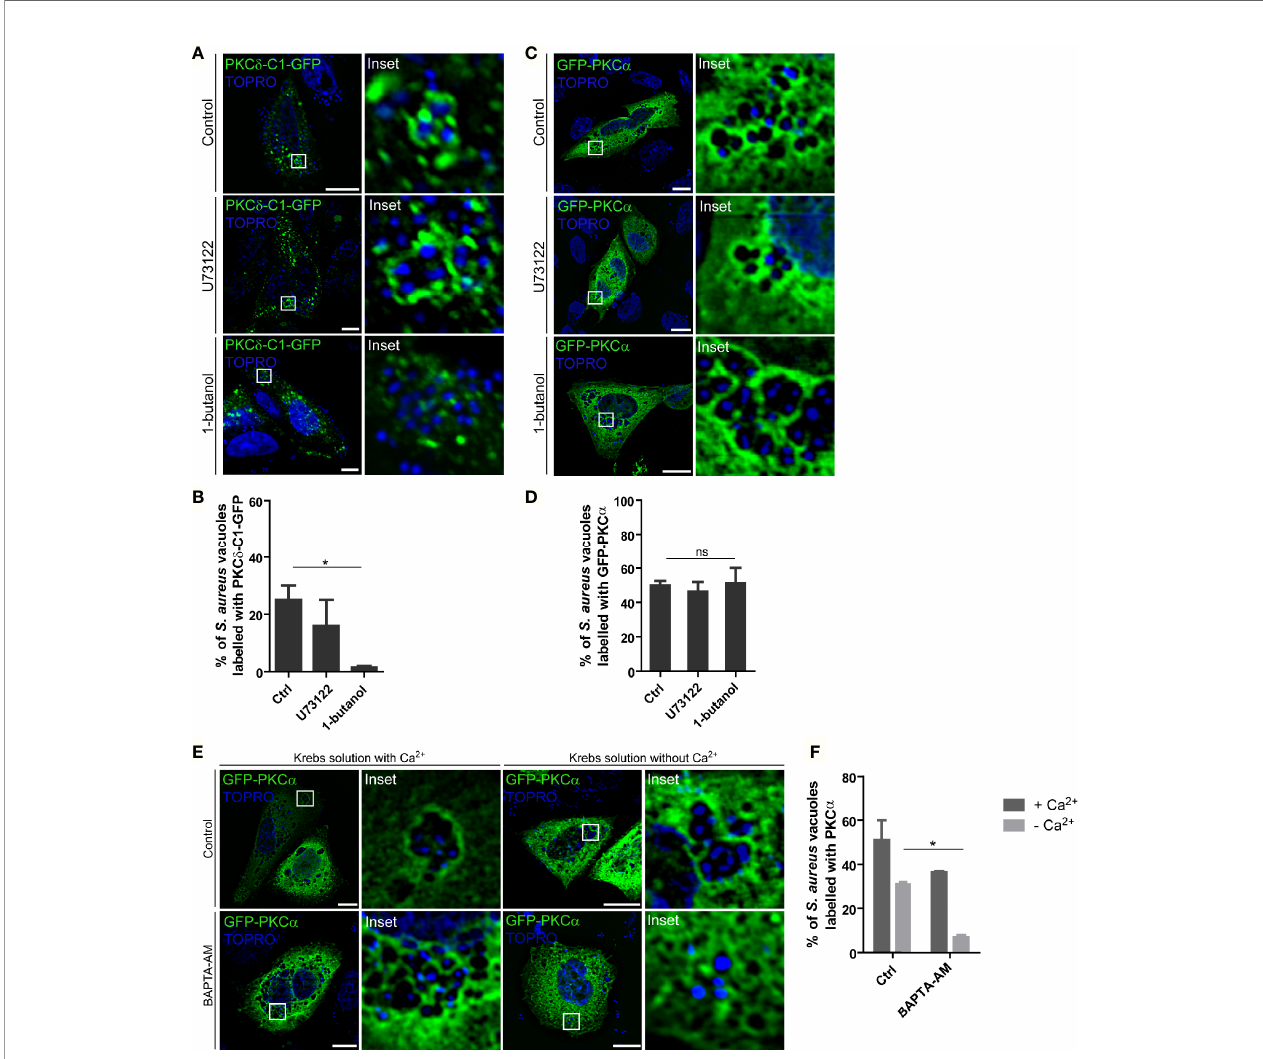
FIGURE 3 | PKC a recruitment to the S. aureus phagosomes is independent of DAG but depends on Ca 2+ . (A) Confocal microscopy images of CHO cells overexpressing PKC d -C1-GFP and treated with the PLC inhibitor, U73122 (1.5 µM), or the PLD inhibitor, 1-butanol (0.3% v/v), and infected for 4 hours with S. aureus wt. Bacteria were labelled with Topro (depicted in blue). Bar: 10µm. Images are representative of three independent experiments. (B) Quanti fi cation of S. aureus vacuoles decorated with PKC d -C1-GFP. Data are the mean ± SEM of three independent experiments. *p ≤ 0.01. (C) Confocal microscopy images of CHO cells overexpressing GFP-PKC a and treated with the PLC inhibitor, U73122 (1.5 µM) and the PLD inhibitor, 1-butanol (0.3% v/v), and infected for 4 hours with S. aureus wt. Bacteria were labelled with Topro (shown in blue). Images are representative of three independent experiments. Bar: 10 m m. (D) Quanti fi cation of S. aureus vacuoles recruiting GFP-PKC a . Data are the mean ± SEM of three independent experiments. (E) Confocal microscopy images of CHO cells overexpressing GFP-PKC a treated with 10 m M BAPTA-AM in Krebs solution with (2.5 mM) or without Ca 2+ and infected with S. aureus wt for 4 hours. Bacteria were labelled with Topro (shown in blue). Bar: 10 m m. Images are representative of three independent experiments. (F) Quanti fi cation of S. aureus vacuoles recruiting GFP-PKC a . Data are the mean ± SEM of three independent experiments. *p ≤